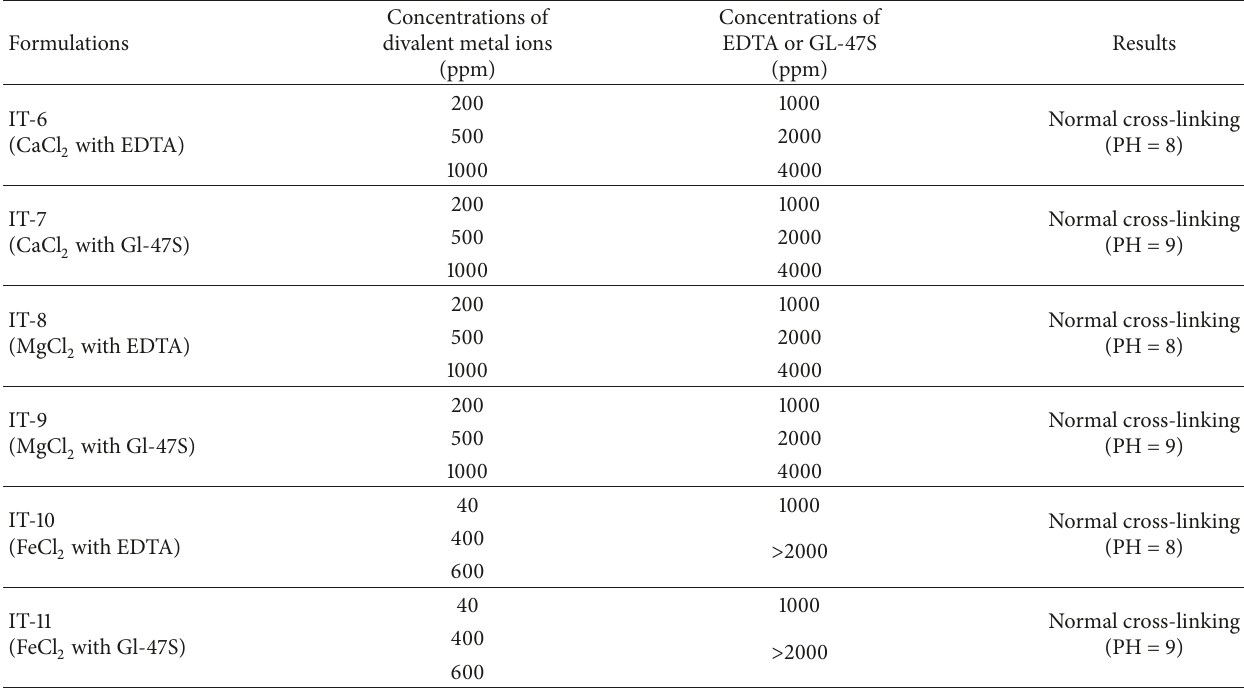
Table 4: Gelation and cross-linking tests for removing different divalent metal ions.